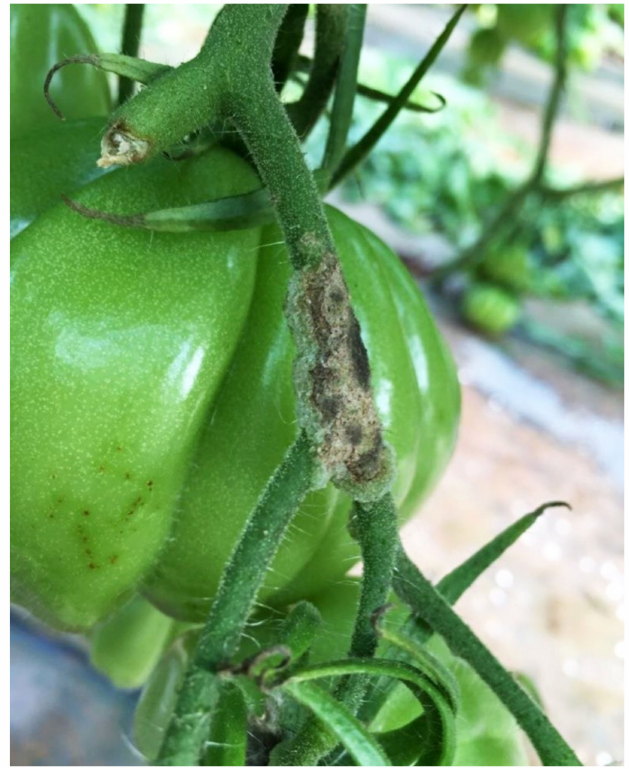
Figure 3. Grey mould on tomato petioles caused by Botrytis cinerea